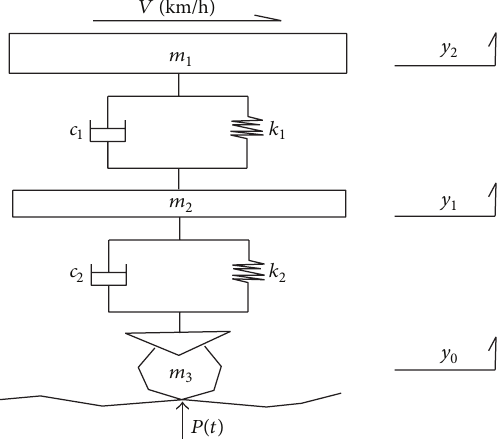
Figure 2: Simplified model of wheel and